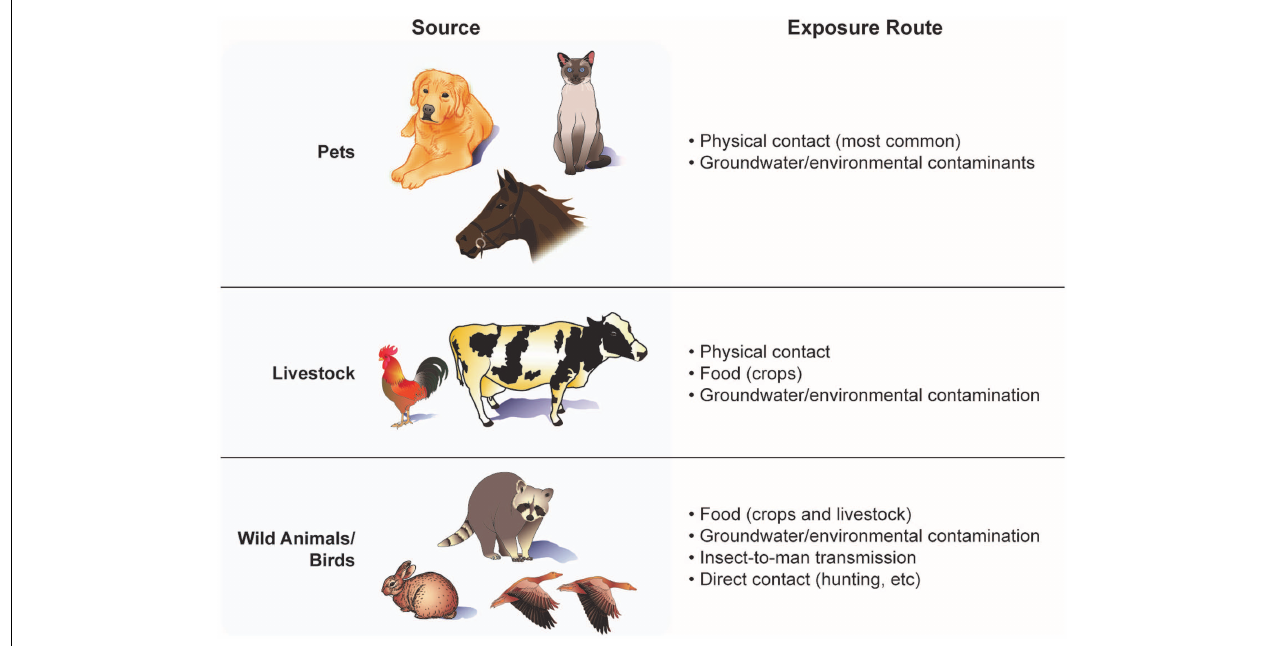
FIGURE 2 | Routes of transmission and human exposure to animal viruses and bacteria